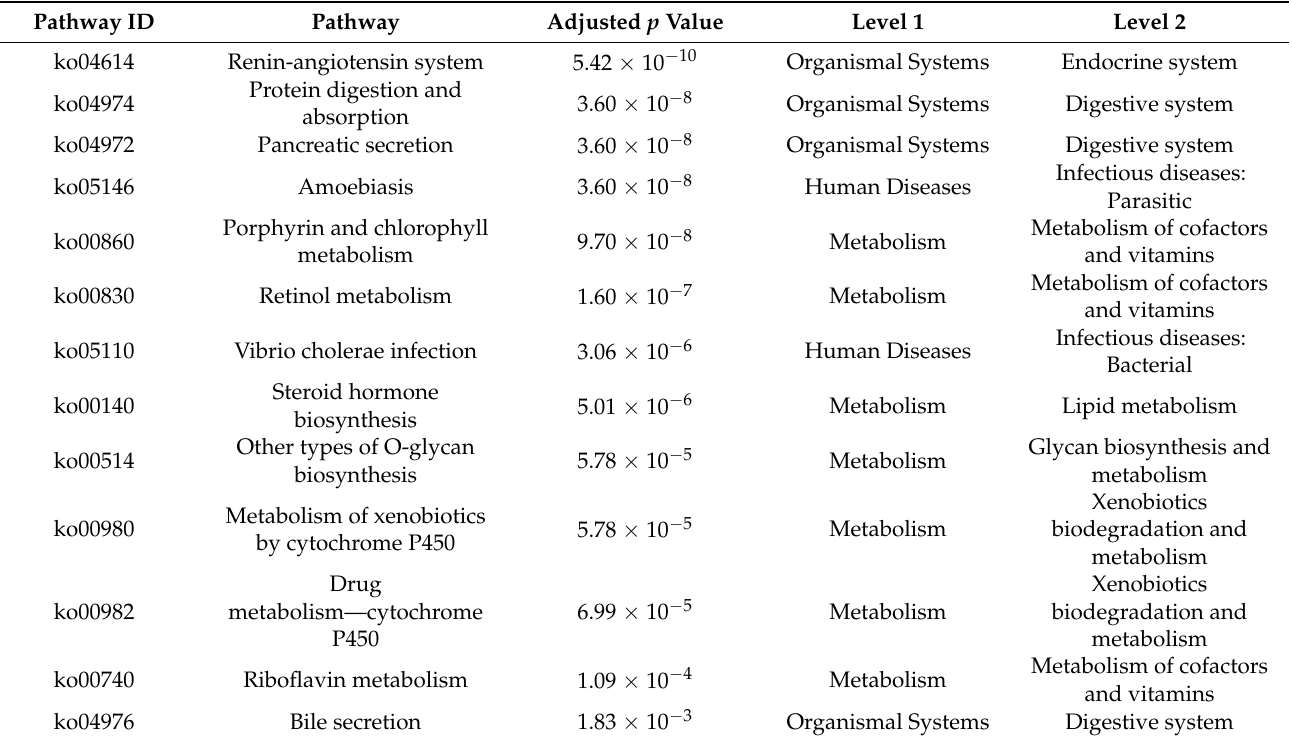
Table 3. KEGG pathway enrichment analyses results for the differentially expressed